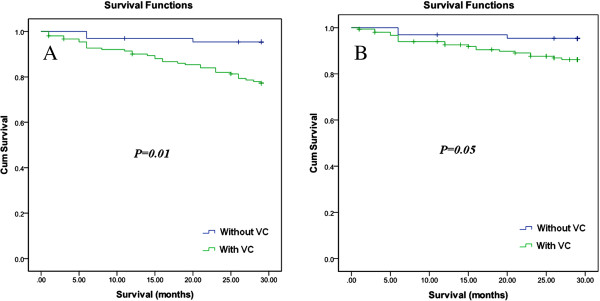
Kaplan-Meier curves for patients with and without vascular calcification. A) All-cause mortality; B) cardiovascular mortality.